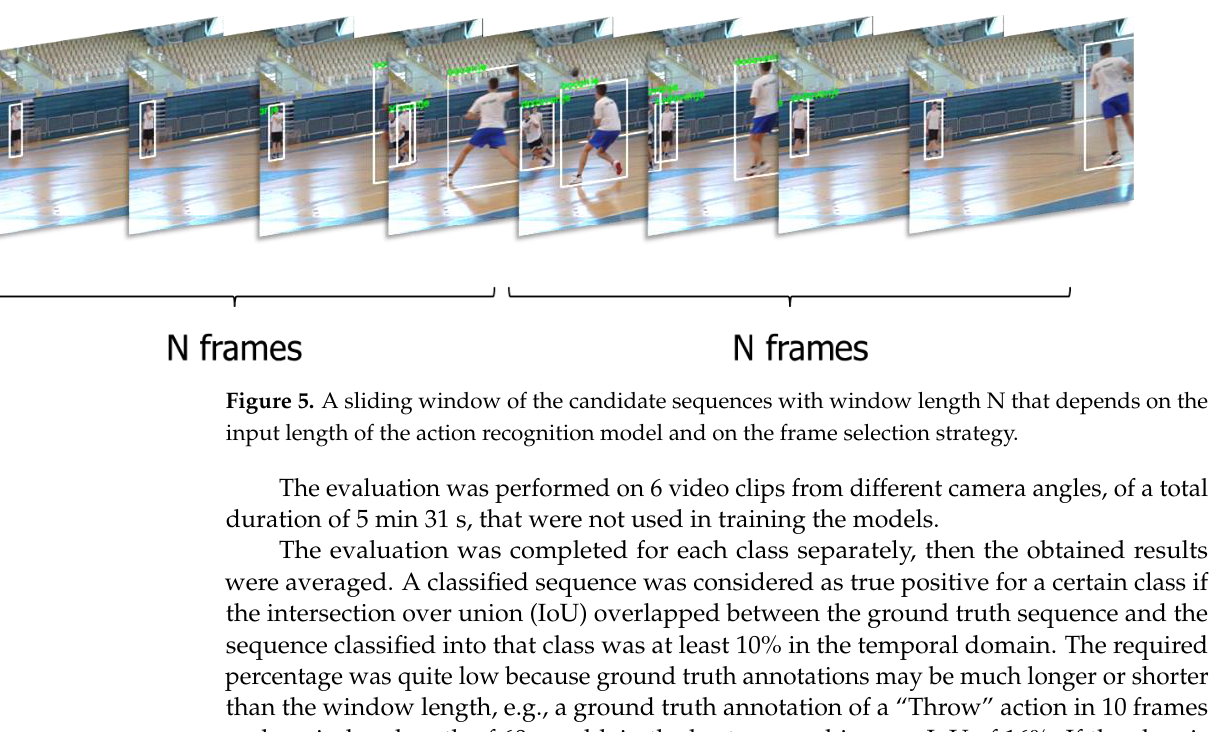
Table 1. Object detection results on UNIRI-HBD dataset. Model